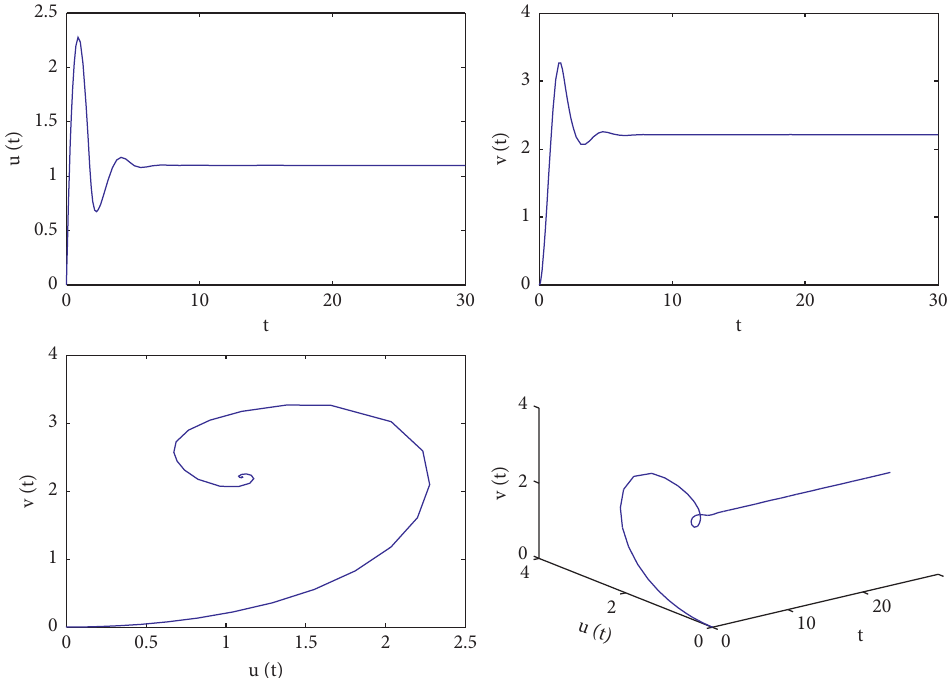
Figure 3: The trajectories graphs and phase graphs of system (94) with τ